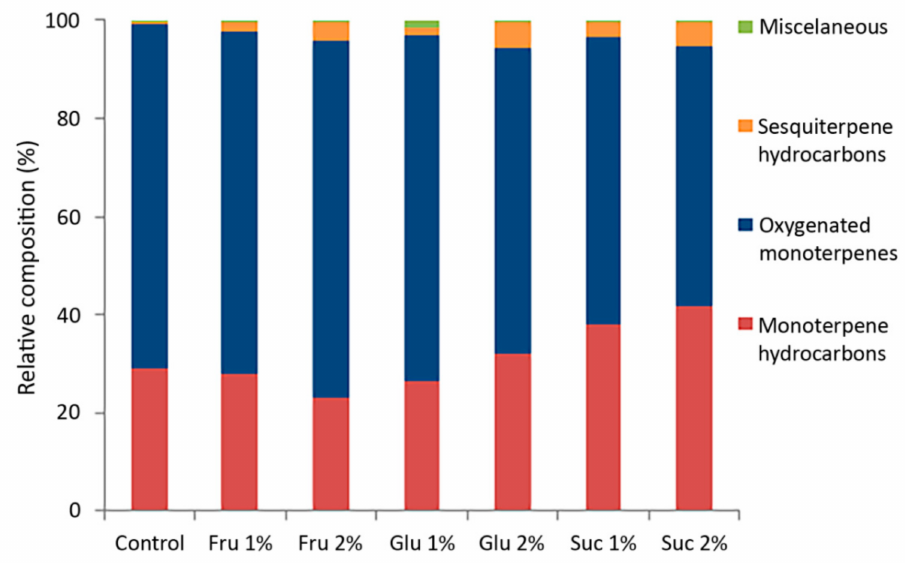
Figure 2. Relative composition (%) of major classes of compounds from in vitro grown Clinopodium pulegium , cultured on media supplemented with different